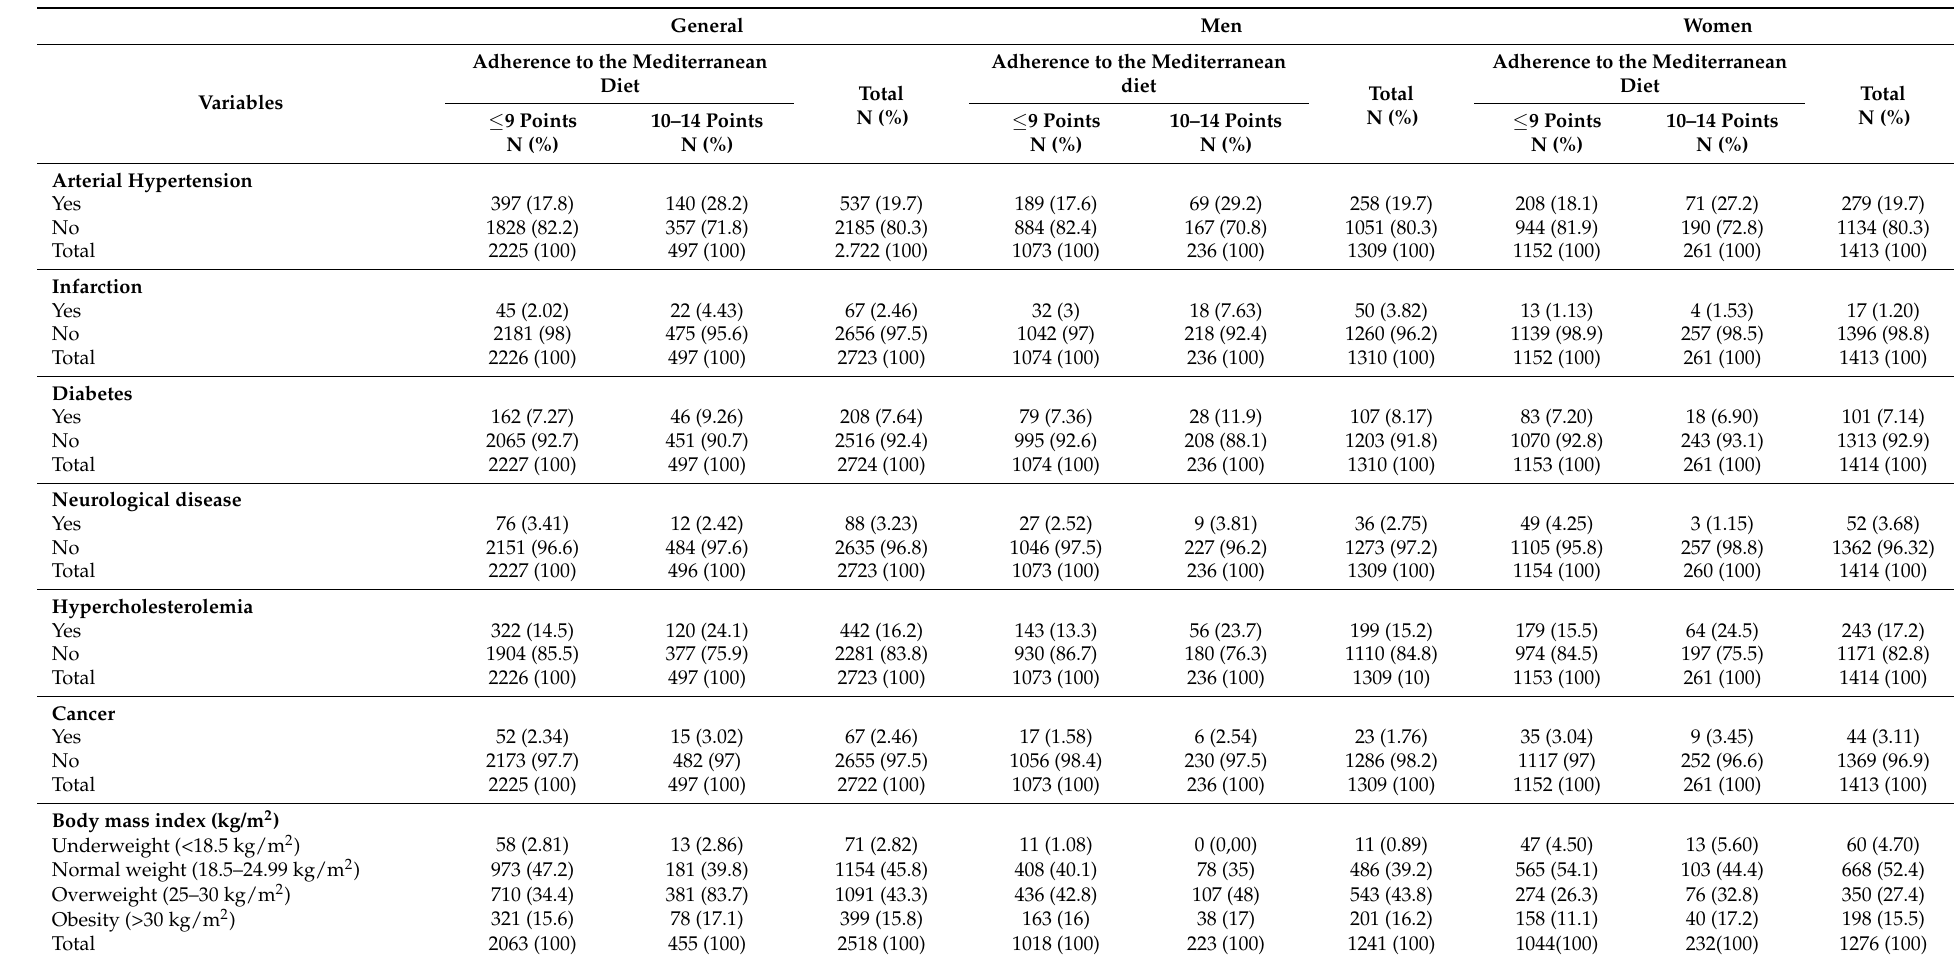
Table 2. Distribution of the sample according to the health status based on the level of adherence to the Mediterranean